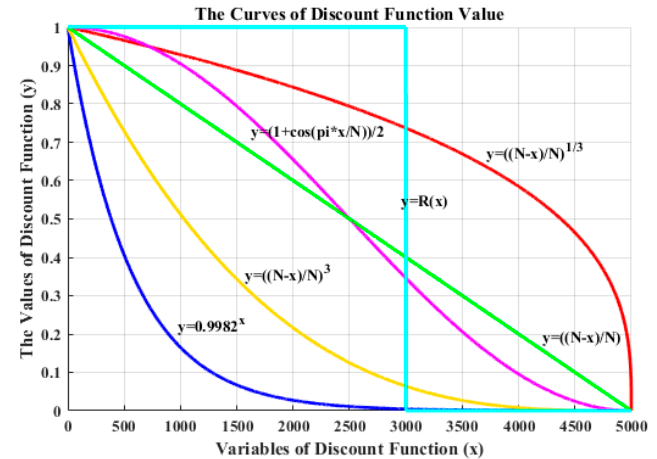
Figure 3. Discount functions studied, and the expression of the function are labeled on the curve.